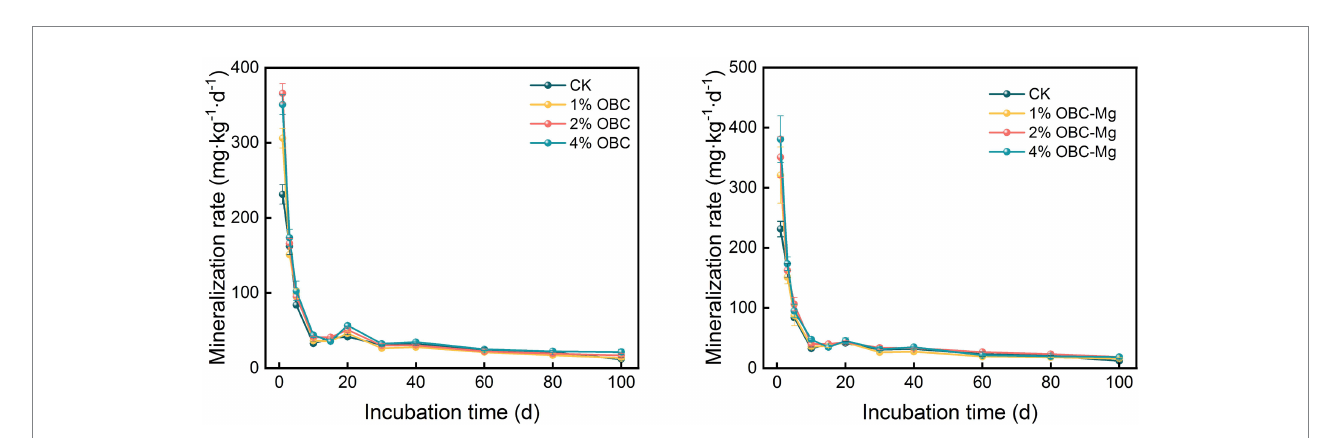
FIGURE 6 Changes in soil mineralization rate after the amendment of OBC and